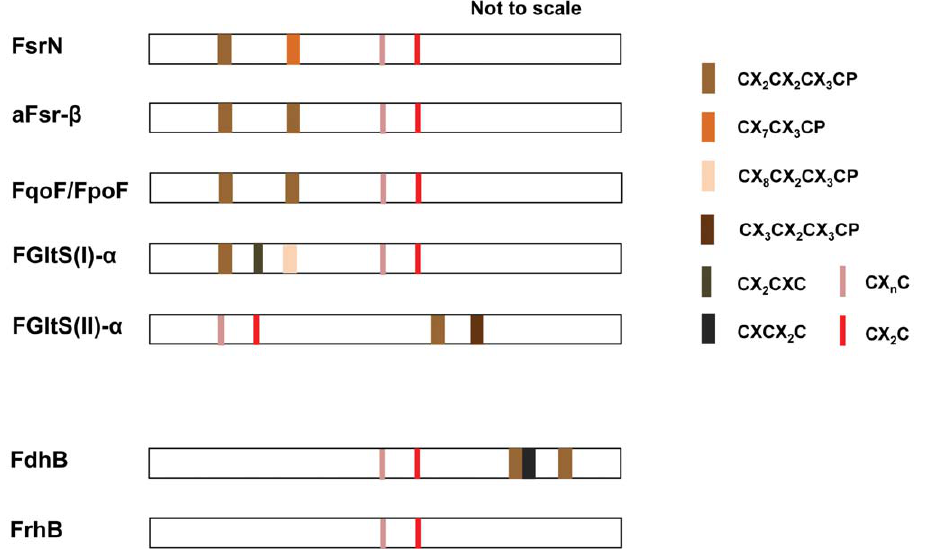
Figure 6. Groups of Fsr-N homologs. The sketches are based on respective amino acid sequence characteristics shown in Fig. S4. FGltS(I)- a and aFsr- b : F 420 H 2 -dehydrogenase subunit of a putative F 420 H 2 -dependent glutamate synthase of methanogens and a putative F 420 H 2 -dependent assimilatory type siroheme sulfite reductase found in haloarchaea; FpoF/FqoF: F 420 H 2 dehydrogenase subunit of a membrane-bound proton pumping F 420 H 2 dehydrogenase complex of late evolving euryarchaea [36]. Note: FGltS(II)- a departs significantly from Fsr-N in primary sequence and it is not included in Fig. S4. F 420 -interacting or b subunits of F 420 H 2 reducing hydrogenase (FrhB) and formate dehydrogenase (FdhB) [67,68] are shown for comparison.